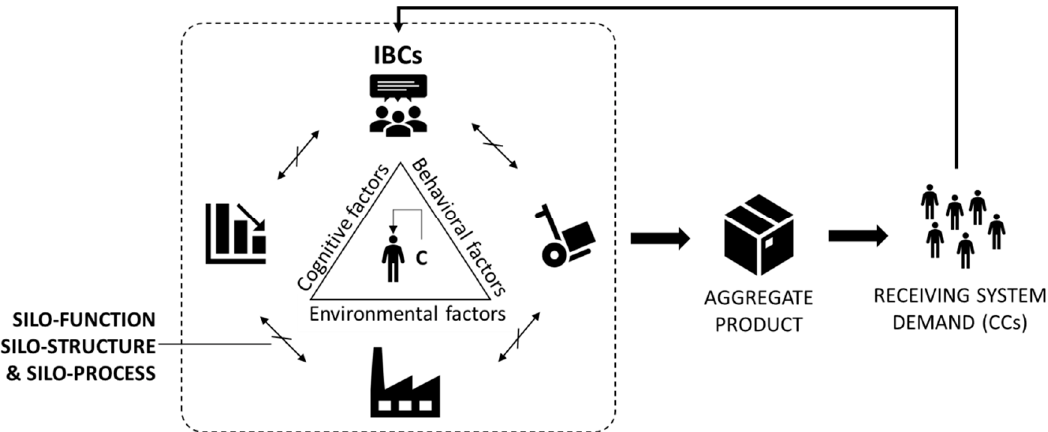
Figure 1. Reciprocal determinism model adapted to an analysis of metacontingencies in a siloed organization example (included in the dashed square). The interrupted bidirectional lines represent the effects of silos depending on the system property derived from the model of social learning (callouts in bold). The metacontingency is comprised of interlocking behavioral contingencies (IBCs), one or more aggregate product(s) (AP), and the receiving system demand. Note: C = consequence at the individual level; CCs = cultural consequences.